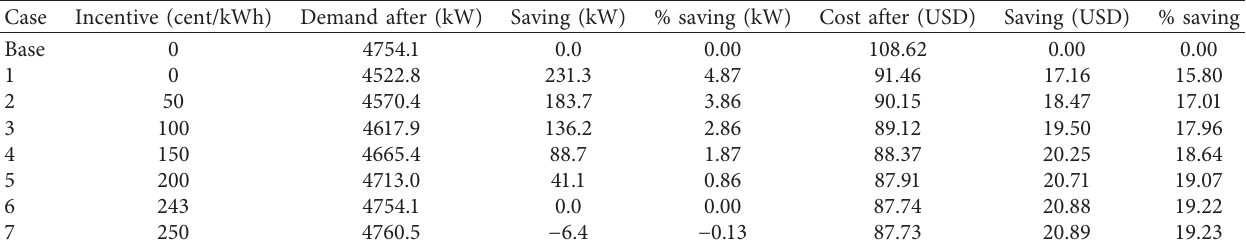
Table 3: Numerical results on energy and cost-saving, a case of LS.